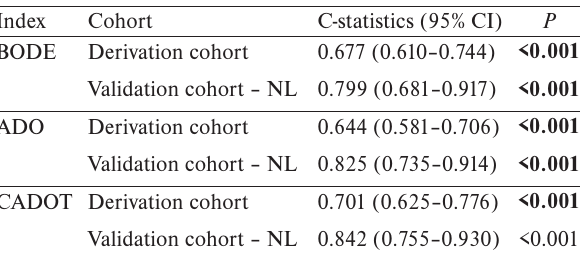
Table 4. ROC analysis – index capacity to separate patients according to